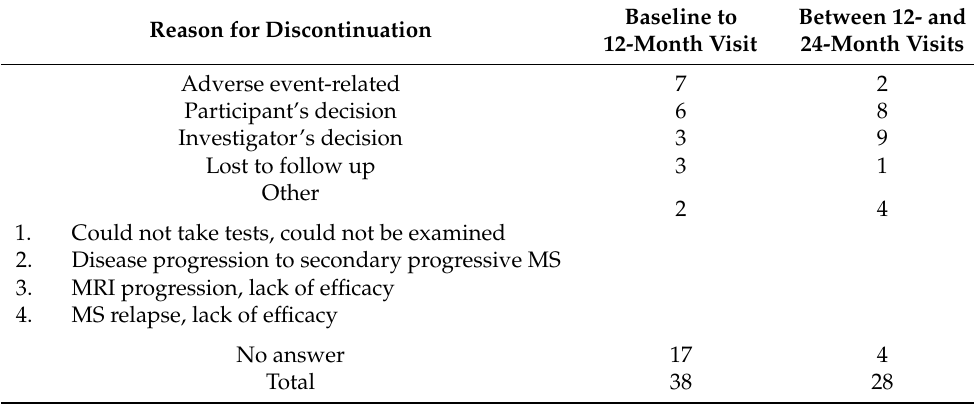
Table 2. Reasons for study discontinuation.